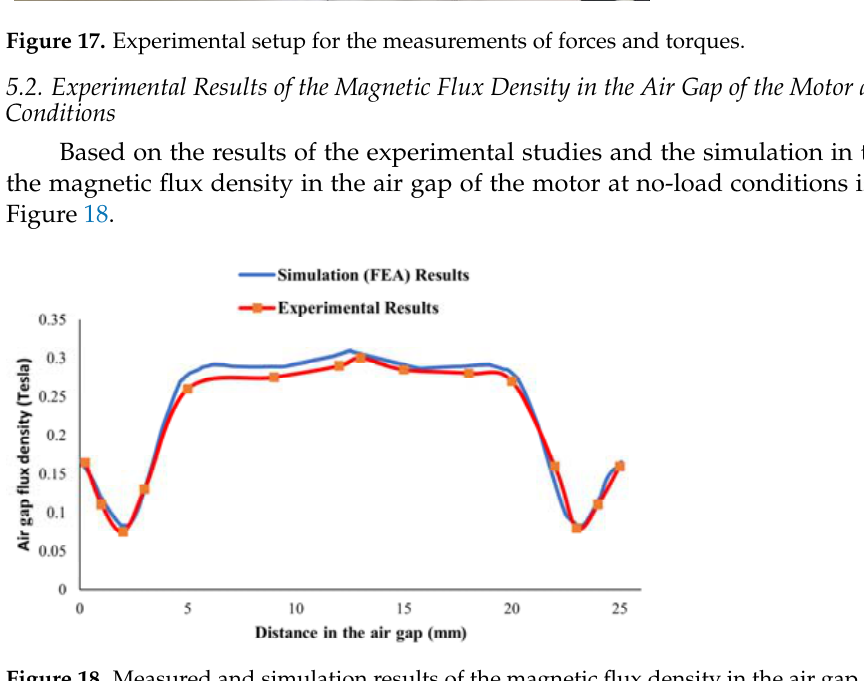
Figure 17. Experimental setup for the measurements of forces and torques.